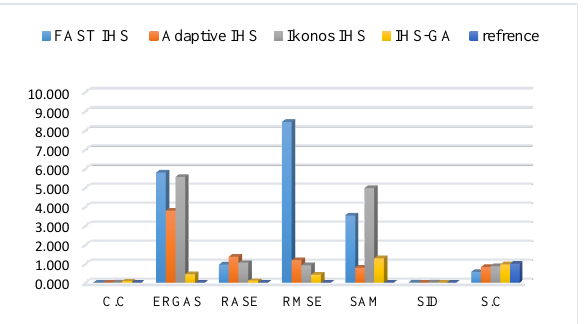
Figure 4. chart of results(QuickBird data sat)